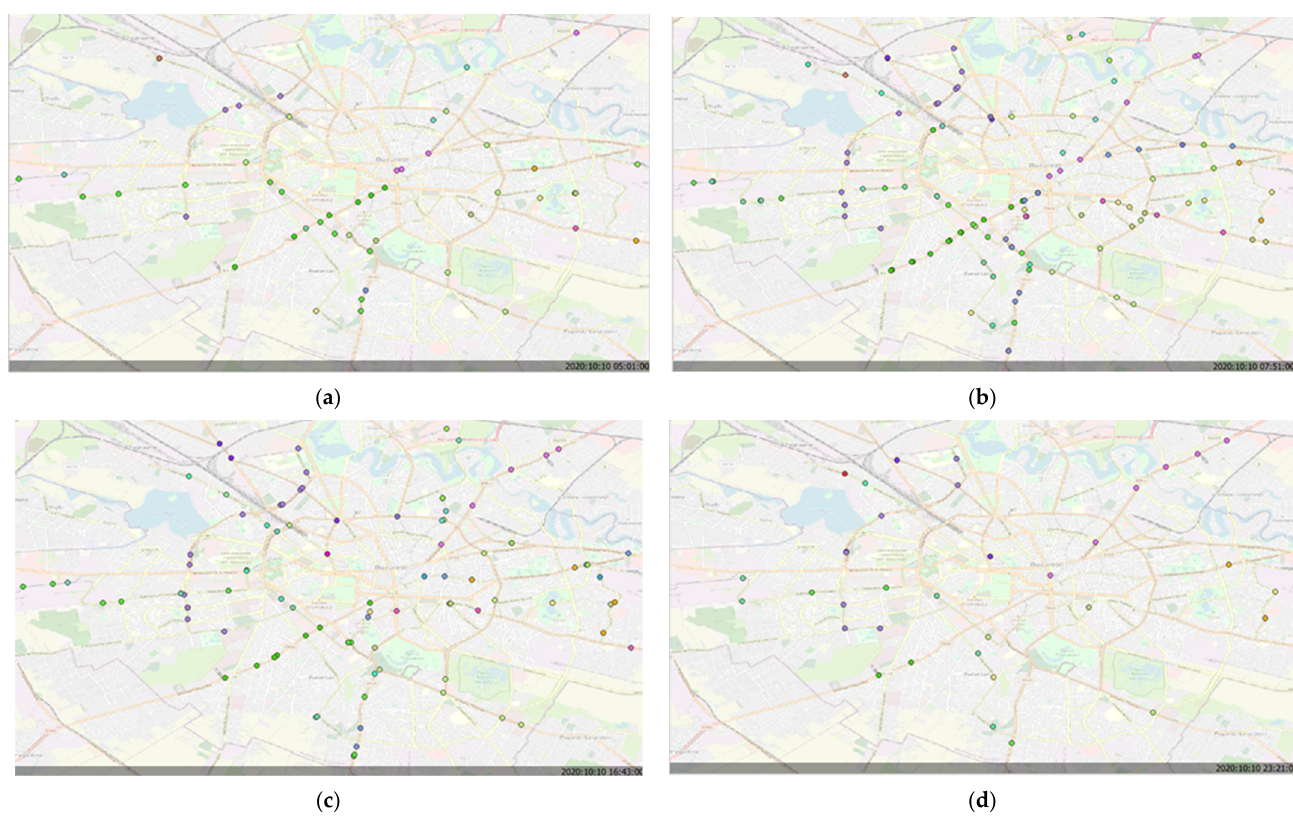
Figure 15. Tram position in several timeslots, each color representing the vehicle position for a specific tramline (e.g., light-green points represent the vehicles operating on tram line no. 8; red points, vehicles on tramline 21) (© OpenStreetMap contributors). ( a ) 05:01. ( b ) 07:51. ( c ) 16:43. ( d ) 23:21.